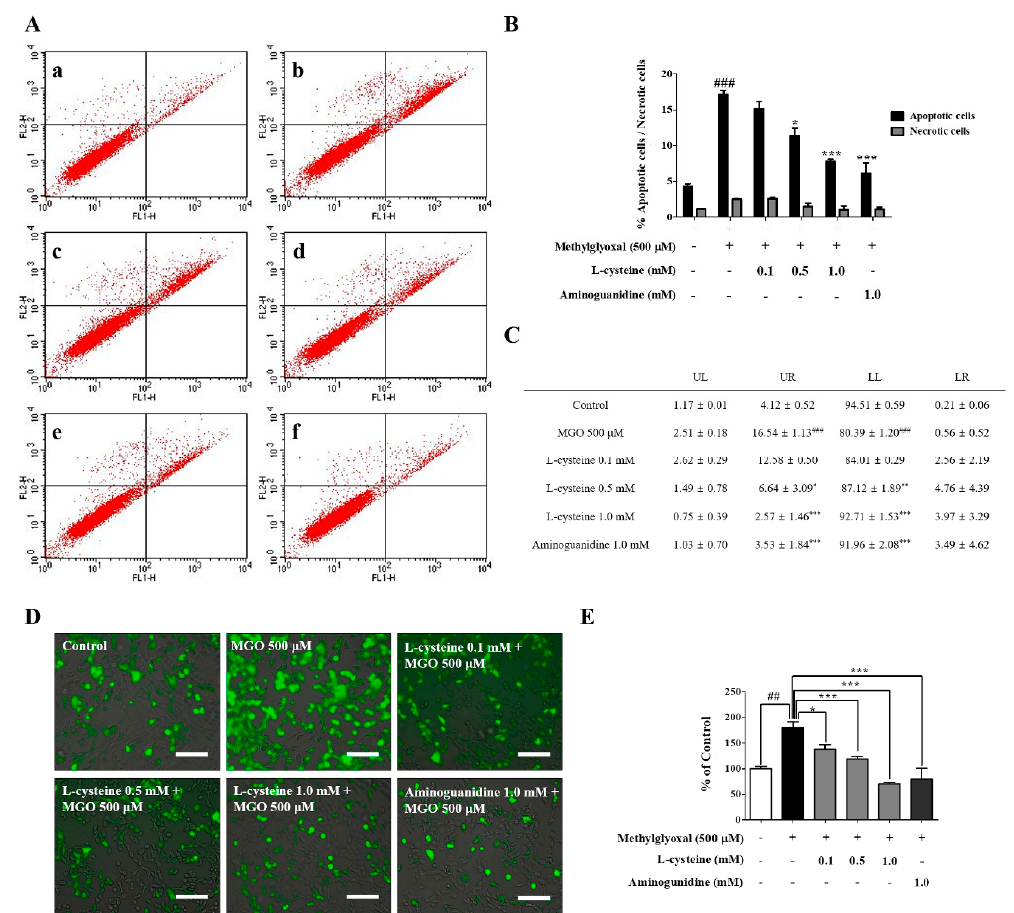
Figure 2. E ff ects of l -cysteine on MGO-induced apoptosis and reactive oxygen species (ROS) generation in MES13 cells. ( A ) Representative cytograms of Annexin V-fluorescein isothiocyanate (FITC) and propidium iodide (PI) staining of MGO-induced MES13 cells. Cells were pretreated with several concentrations l -cysteine for 1 h, then incubated with MGO (500 µ M) for 24 h. After 24 h, the concentrations of viable (Annexin V-FITC and PI negative cells), early-stage apoptotic (Annexin V-FITC positive, PI negative cells), late-stage apoptotic (Annexin V-FITC positive, PI-positive cells), and necrotic (PI-positive cells) cells were analyzed by flow cytometry. ( a ) control; ( b ) 500 µ M MGO; ( c ) MGO + l -cysteine (0.1 mM); ( d ) MGO + l -cysteine (0.5 mM); ( e ) MGO + l -cysteine (1.0 mM); ( f ) MGO + AG (1.0 mM) as a positive control. ( B,C ) Quantitative data of representative cytograms of Annexin V-FITC and PI staining. Percentage of control (LL), early-stage apoptotic (LR), late-stage apoptotic (UR), and necrotic cells (UL) as analyzed using BD CellQuest Pro software. ( D ) MES13 cells were pretreated with l -cysteine for 1 h, followed by 500 µ M MGO for 1 h. Green fluorescence (ROS generation) from 2 (cid:48) ,7 (cid:48) -Dichlorofluorescin diacetate (DCF-DA) was examined by JuLI live-cell imaging system. Scale bar indicates 500 µ m. ( E ) Quantitative measurements of fluorescent intensity were evaluated using Image J software. All data are presented as mean ± SEM. n = 3 (## p < 0.01, ### p < 0.001 vs. Control, * p < 0.05, ** p < 0.01, *** p < 0.001 vs. MGO 500 µ